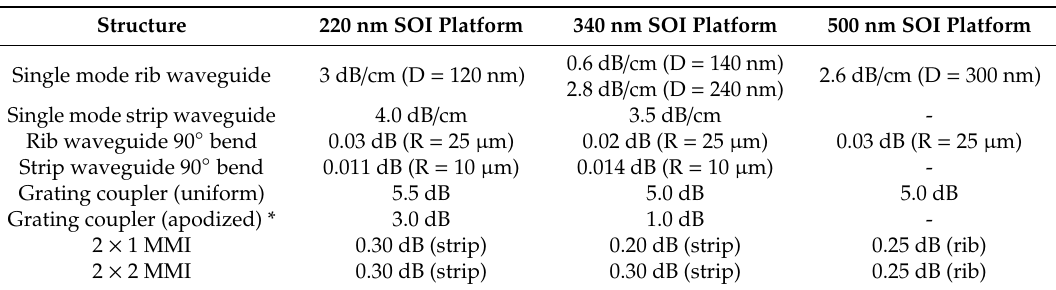
Table 2. Typical insertion loss of standard CORNERSTONE devices in various SOI platforms at a wavelength of 1550 nm (TE mode). Single mode (SM) waveguide width = 450 nm. R = bend radius. D = etch depth. MMI = multi-mode interferometer.